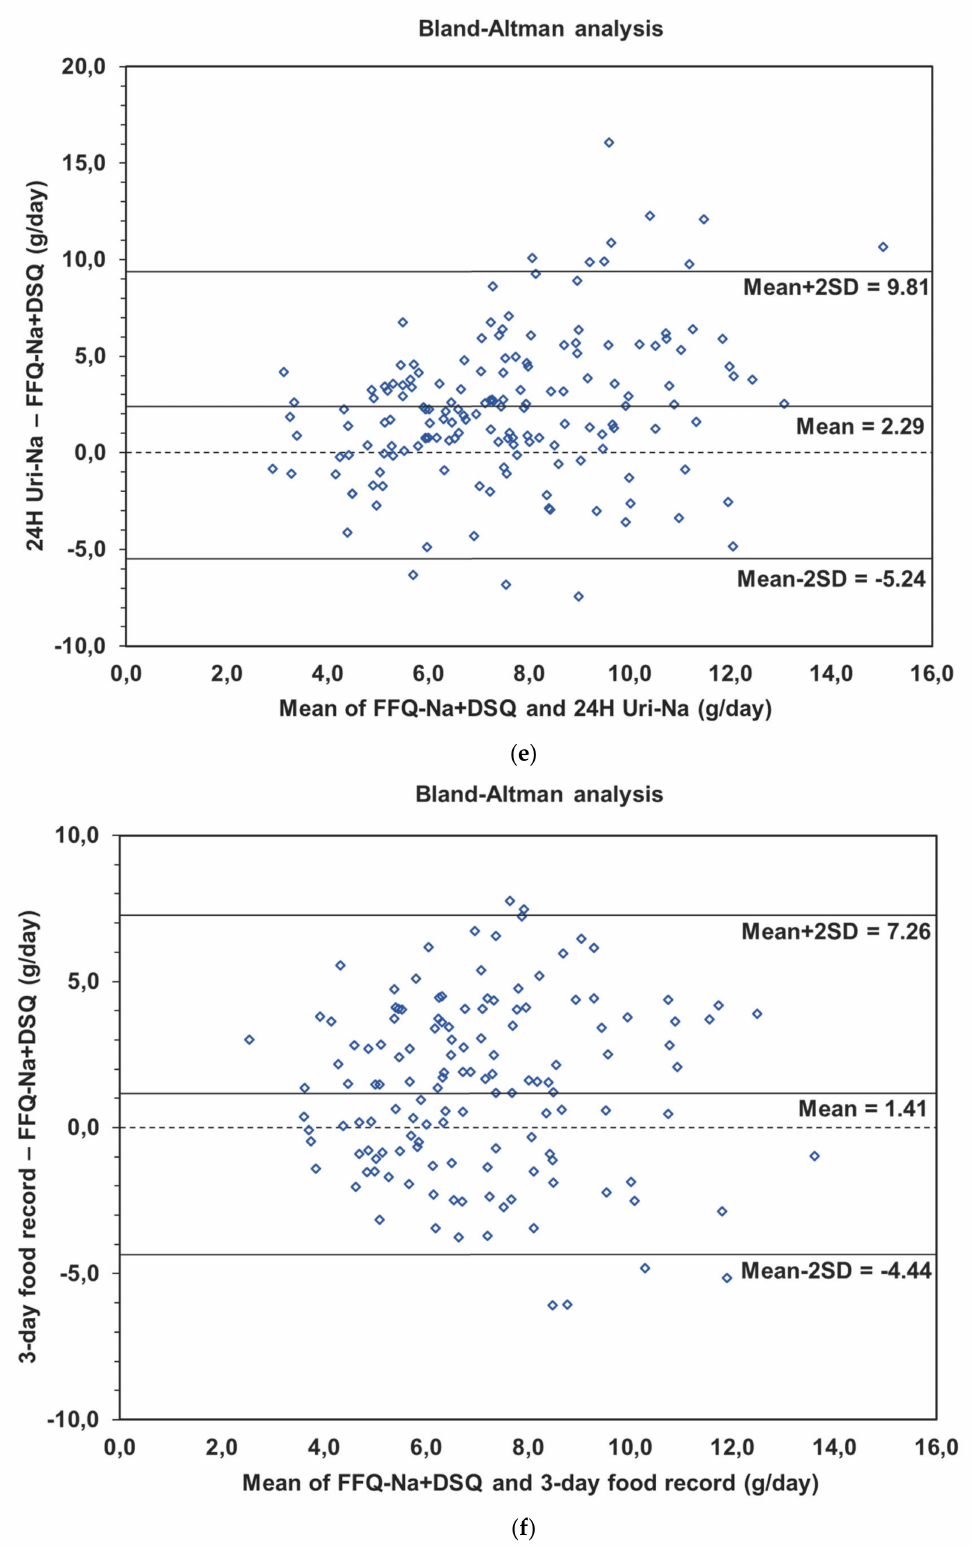
Figure 1. ( a ) Bland-Altman for the DSQ and the 24 h Uri-Na. ( b ) Bland-Altman for the DSQ and the 3-day food record. ( c ) Bland-Altman for the FFQ-Na and the 24 h Uri-Na. ( d ) Bland-Altman for the FFQ-Na and the 3-day food record. ( e ) Bland-Altman for the FFQ-Na + DSQ and the 24 h Uri-Na. ( f ) Bland-Altman for the FFQ-Na + DSQ and the 3-day